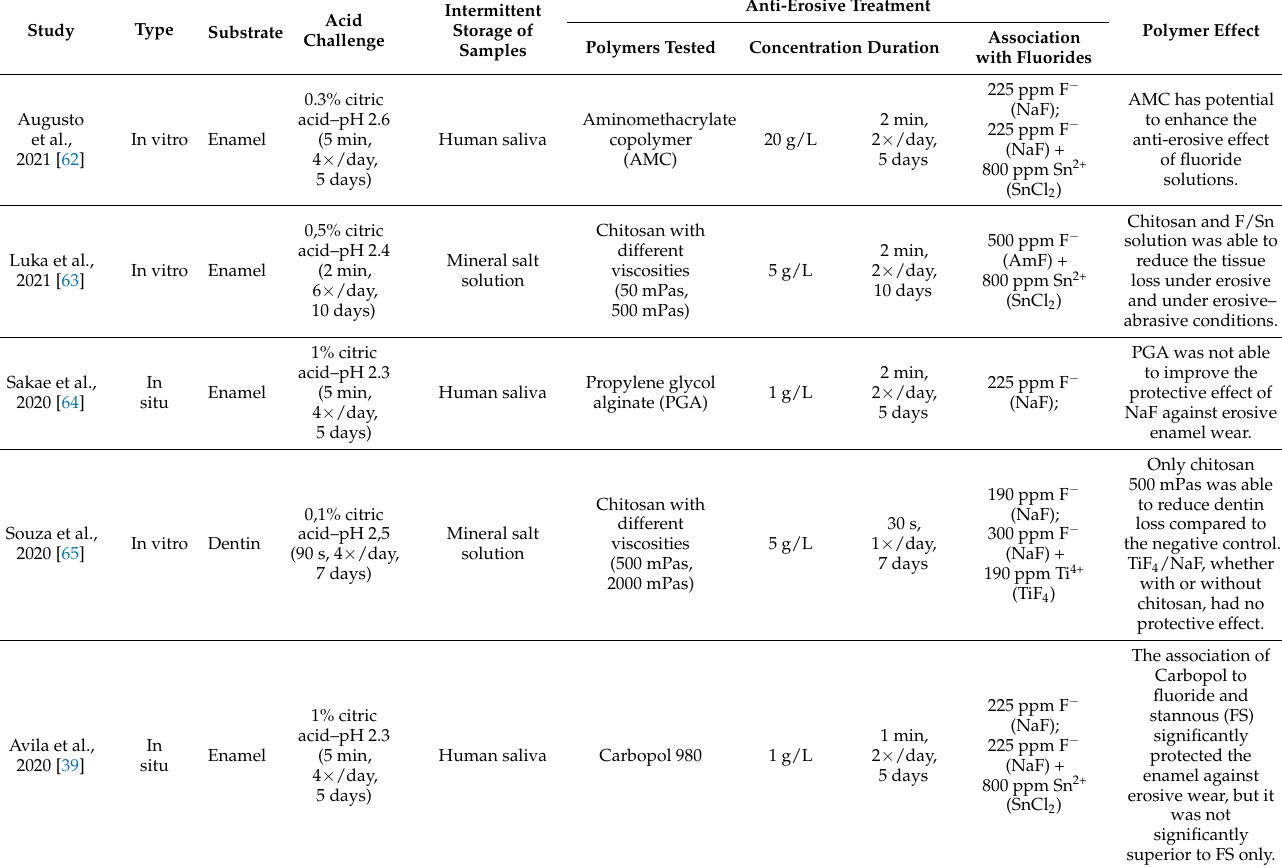
Table 1. Compilation of studies investigating the anti-erosive effect of polymer-based solutions (ordered by publication